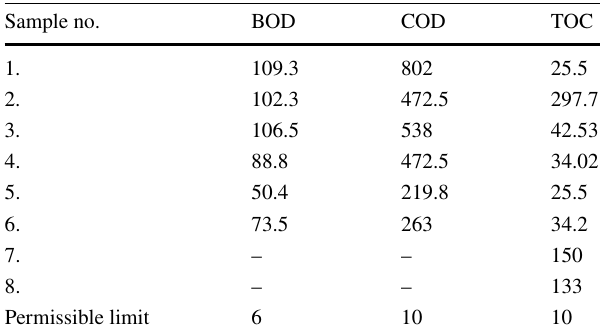
Permissible limit